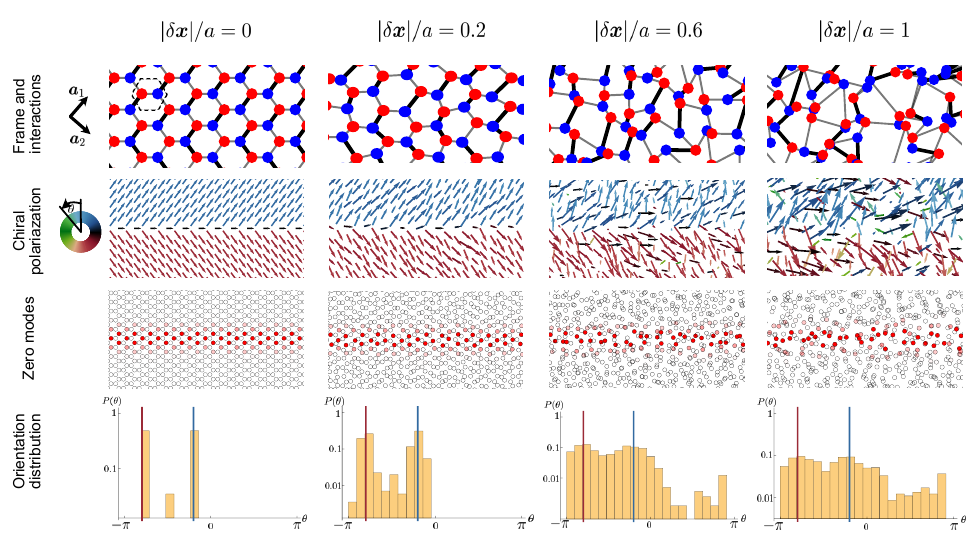
Figure 6: Topological zero energy states on amorphous frames First row: Sketch of the frame geometry for increasing positional disorder quantified by the maximal amplitude of the random displacements | δ x | / a . All panels show the vicinity of a boundary between two different insulators defined on the same frame but with dif- ferent positions of the stronger couplings. The lines’ width indicates the magnitude of the coupling strength. In all panels t (cid:48) / t = 20. In the lefmost panel, we indicate the choice of the unit cell and of the crystallographic axes. Second row: Correspond- ing chiral polarization fields. The color indicates the orientation of Π ( x ) Third row: Magnitude of the zero-mode wave function. The zero mode is located at the bound- ary between topologically inequivalent states even on amorphous frames. Fourth row: Probability density function of the θ , the local orientation of the chiral polar- ization field. The distributions are peaked on the same two directions (vertical lines) regardless of the magnitude of disorder. This reveals the coexistence of two distinct topological phases robust to positional